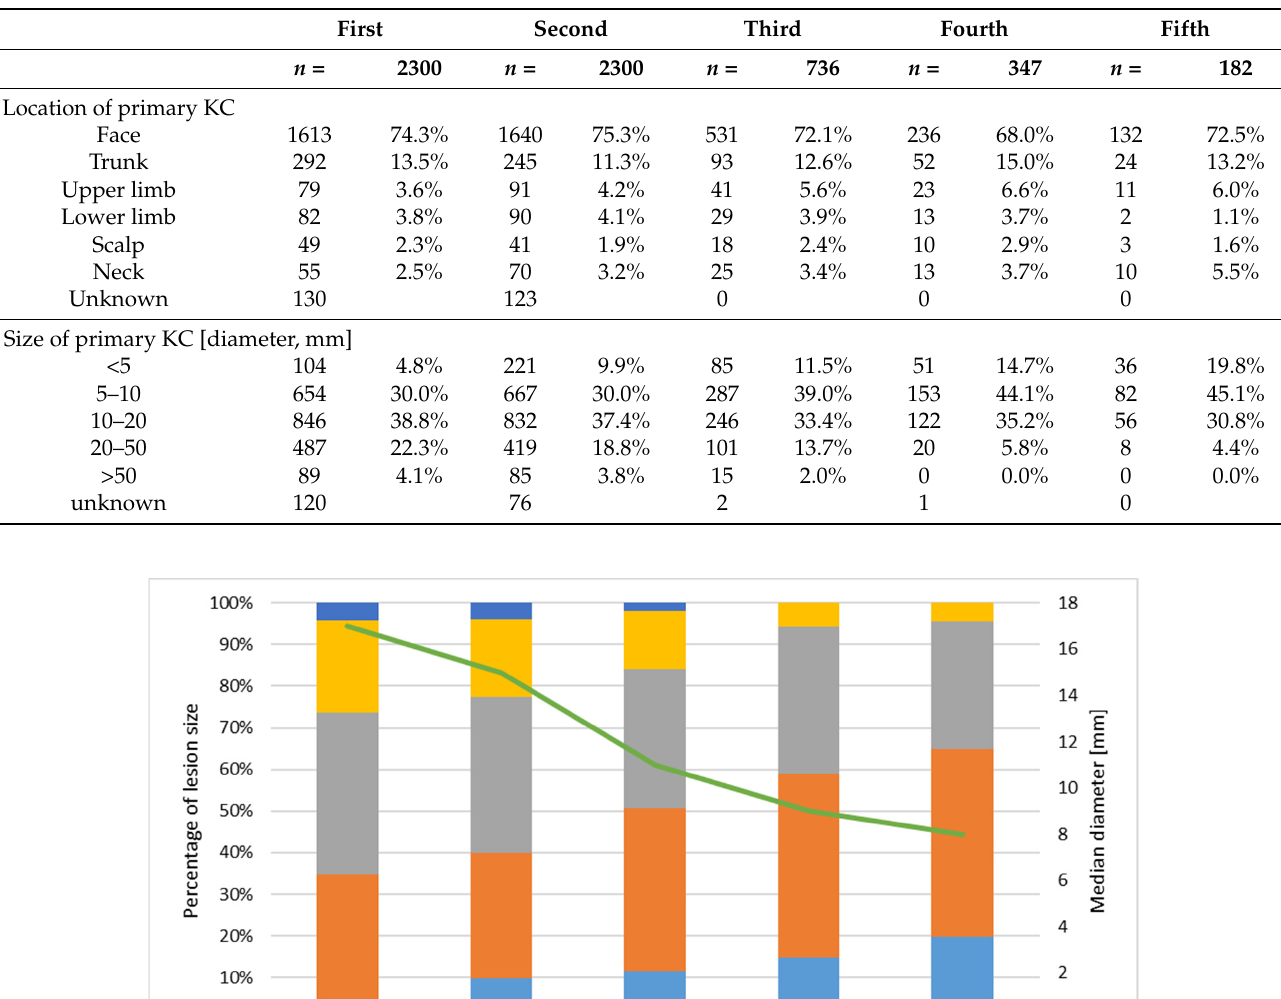
Table 5. Pathological characteristics of multiple KC.